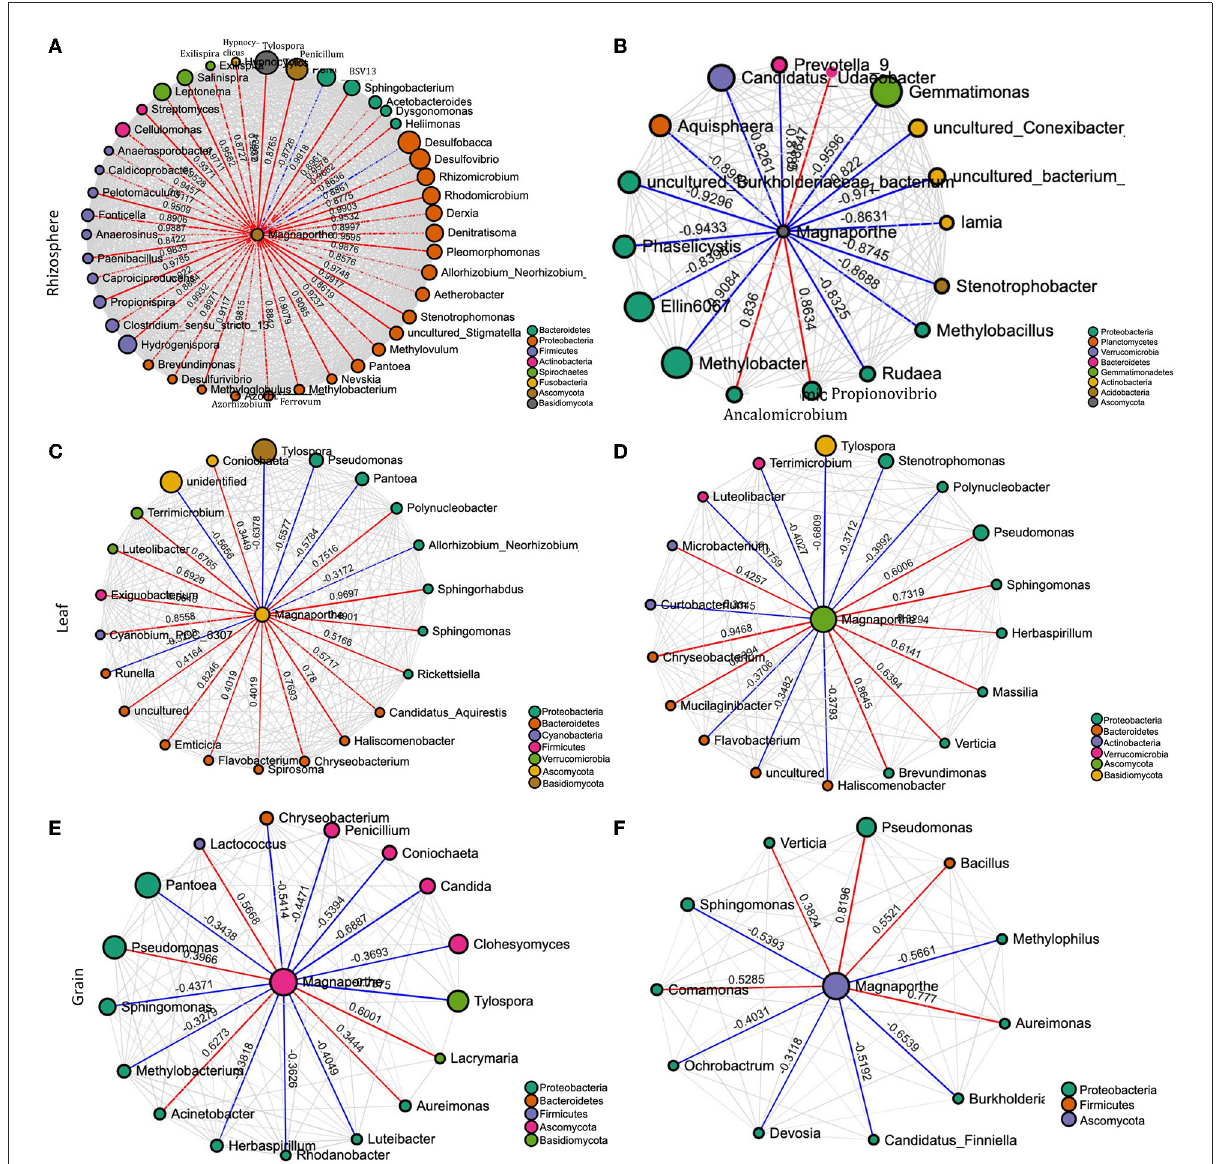
FIGURE4 Network of interactions between the pathogen ( M. oryzae ) and other species in the rhizosphere of healthy (A) and diseased plants (B) , non–symptomatic (C) and symptomatic leaf (D) , and non-symptomatic (E) and symptomatic grain (F). The size of the bubbles corresponds to their relative abundances. The red and blue colors of the edge represent positive and negative interaction with M. oryzae ,